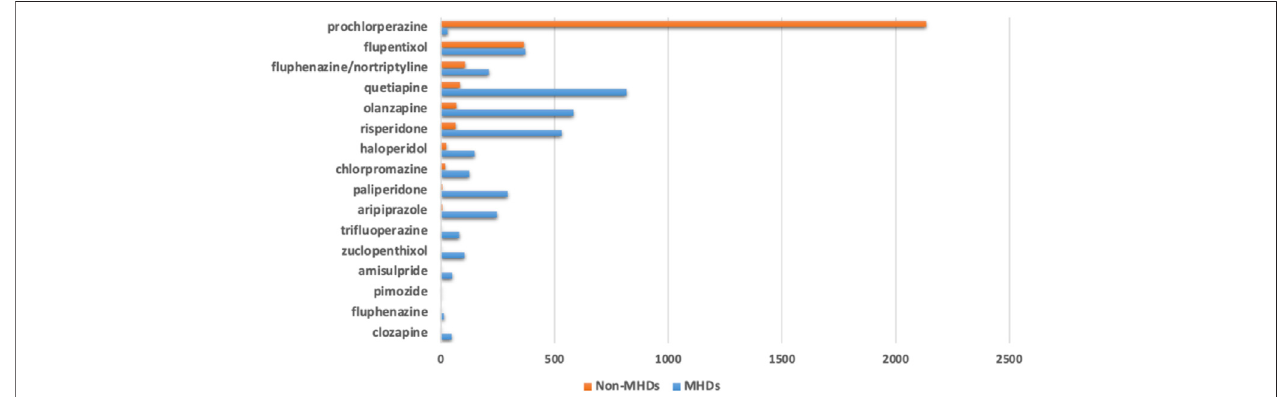
FIGURE 2 | Number of antipsychotic prescriptions based on their diagnostic indications classi fi ed into mental health disorders (MHDs) or non-mental health disorders (Non-MHDs).